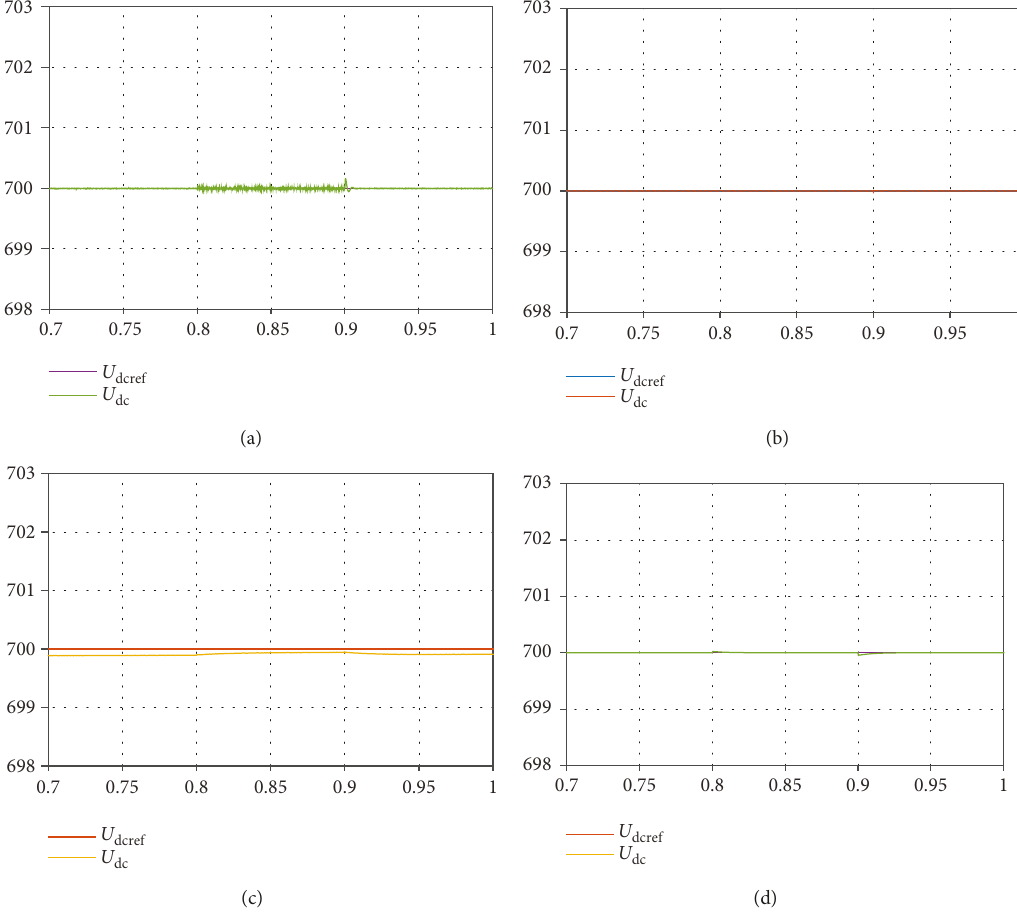
Figure 17: Voltage dip e ff ect on DC link voltage without limitation by using (a) PSO-PID; (b) TLBO-FOPID; (c) ACO-PID; (d)